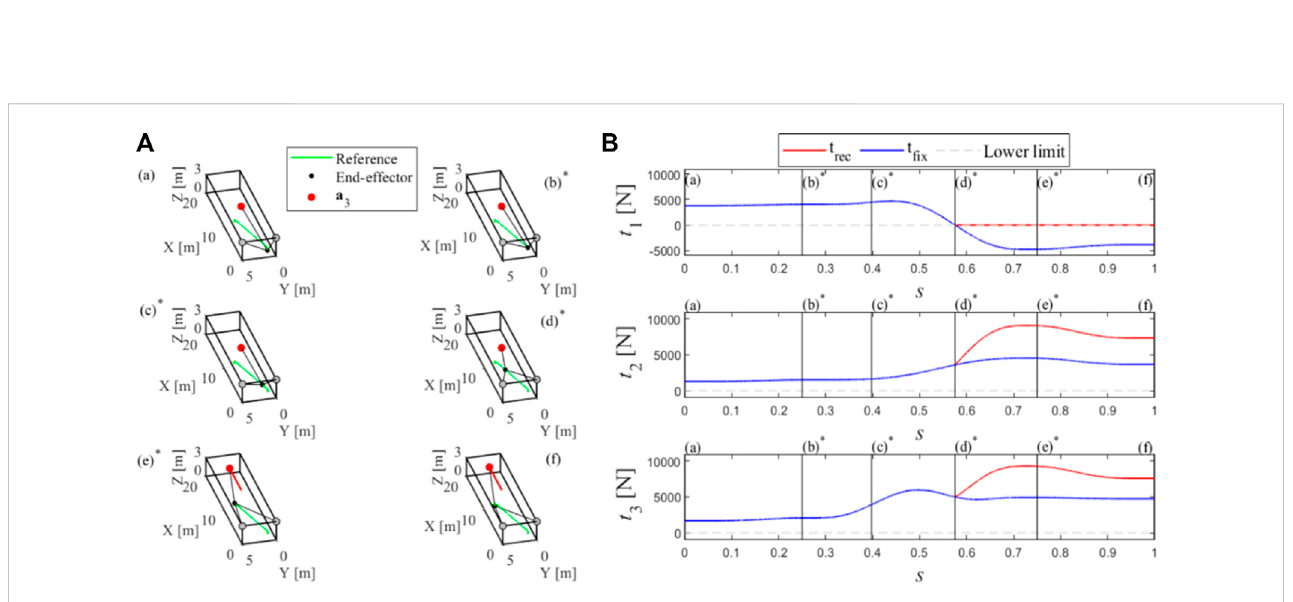
FIGURE 4 Recon fi guration of the exit-point (A) and cable tensions (B) along the path.